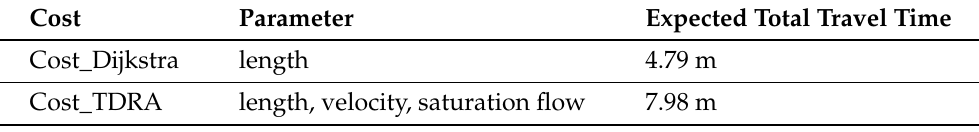
Table 1. Comparison total travel time considering the cost parameters with Dijkstra’s algorithm.